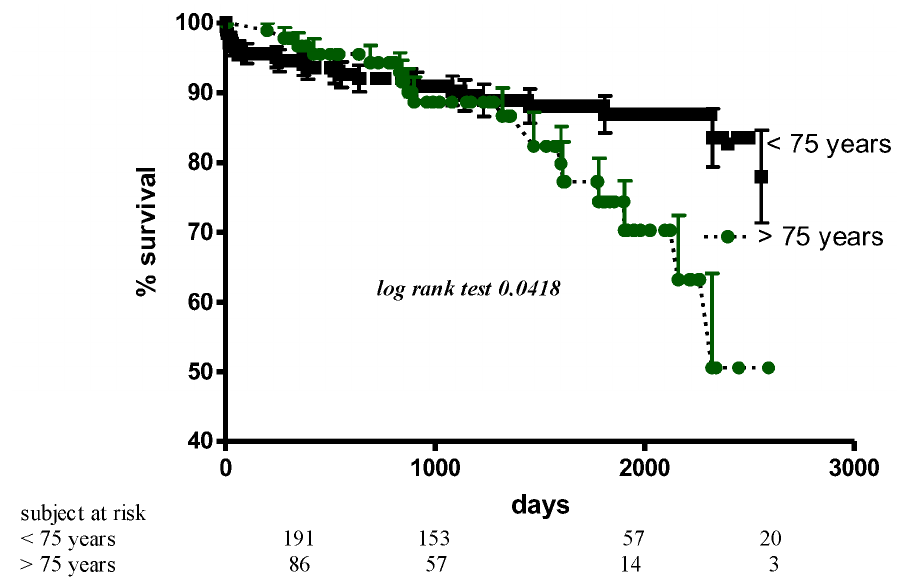
Figure 1. Kaplan–Meier survival curves according to